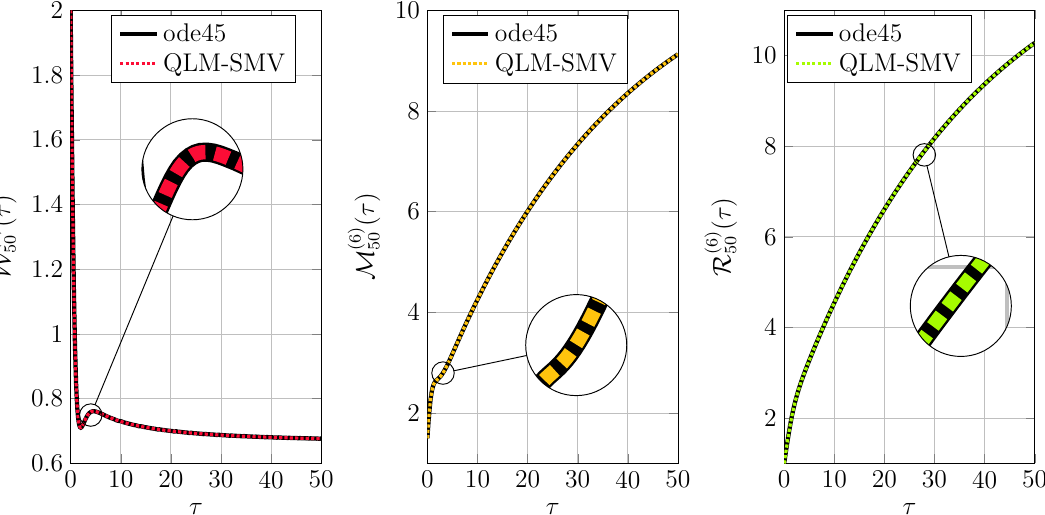
Figure 6. Comparisons of numerical solutions obtained via QLM-SMV in Test Case 2 with Q =